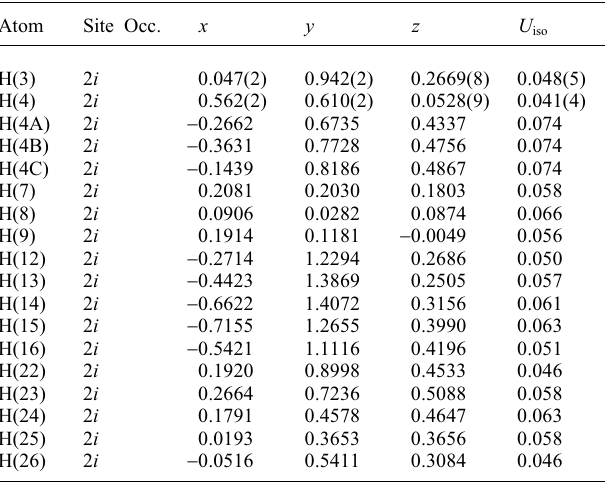
Table 3. Atomic coordinates and displacement parameters (in Å 2 ) .